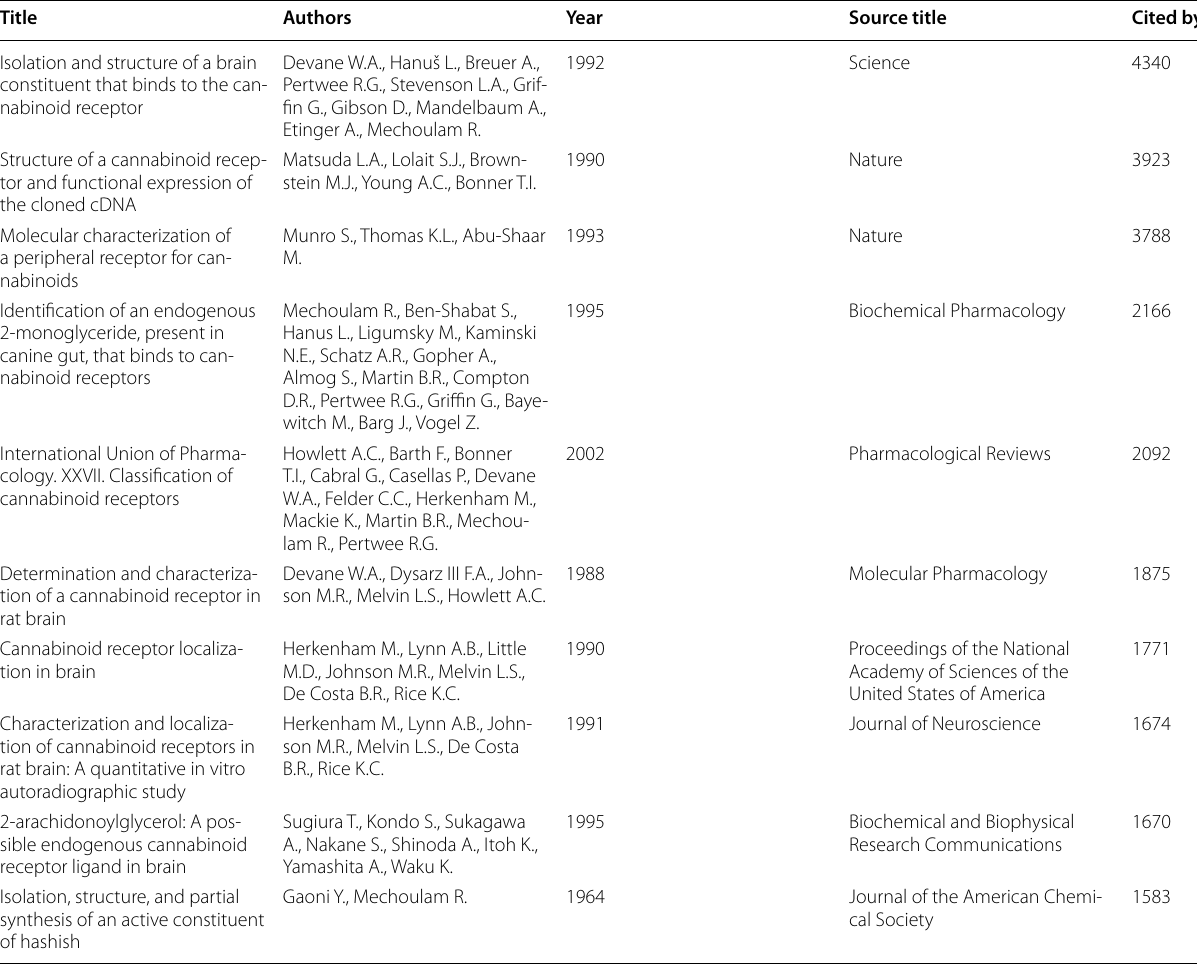
All data was collected from